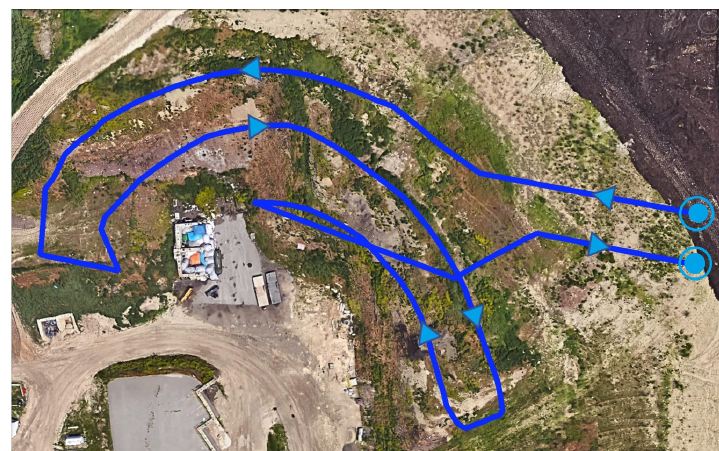
Figure 5. Flight path around area of interest.